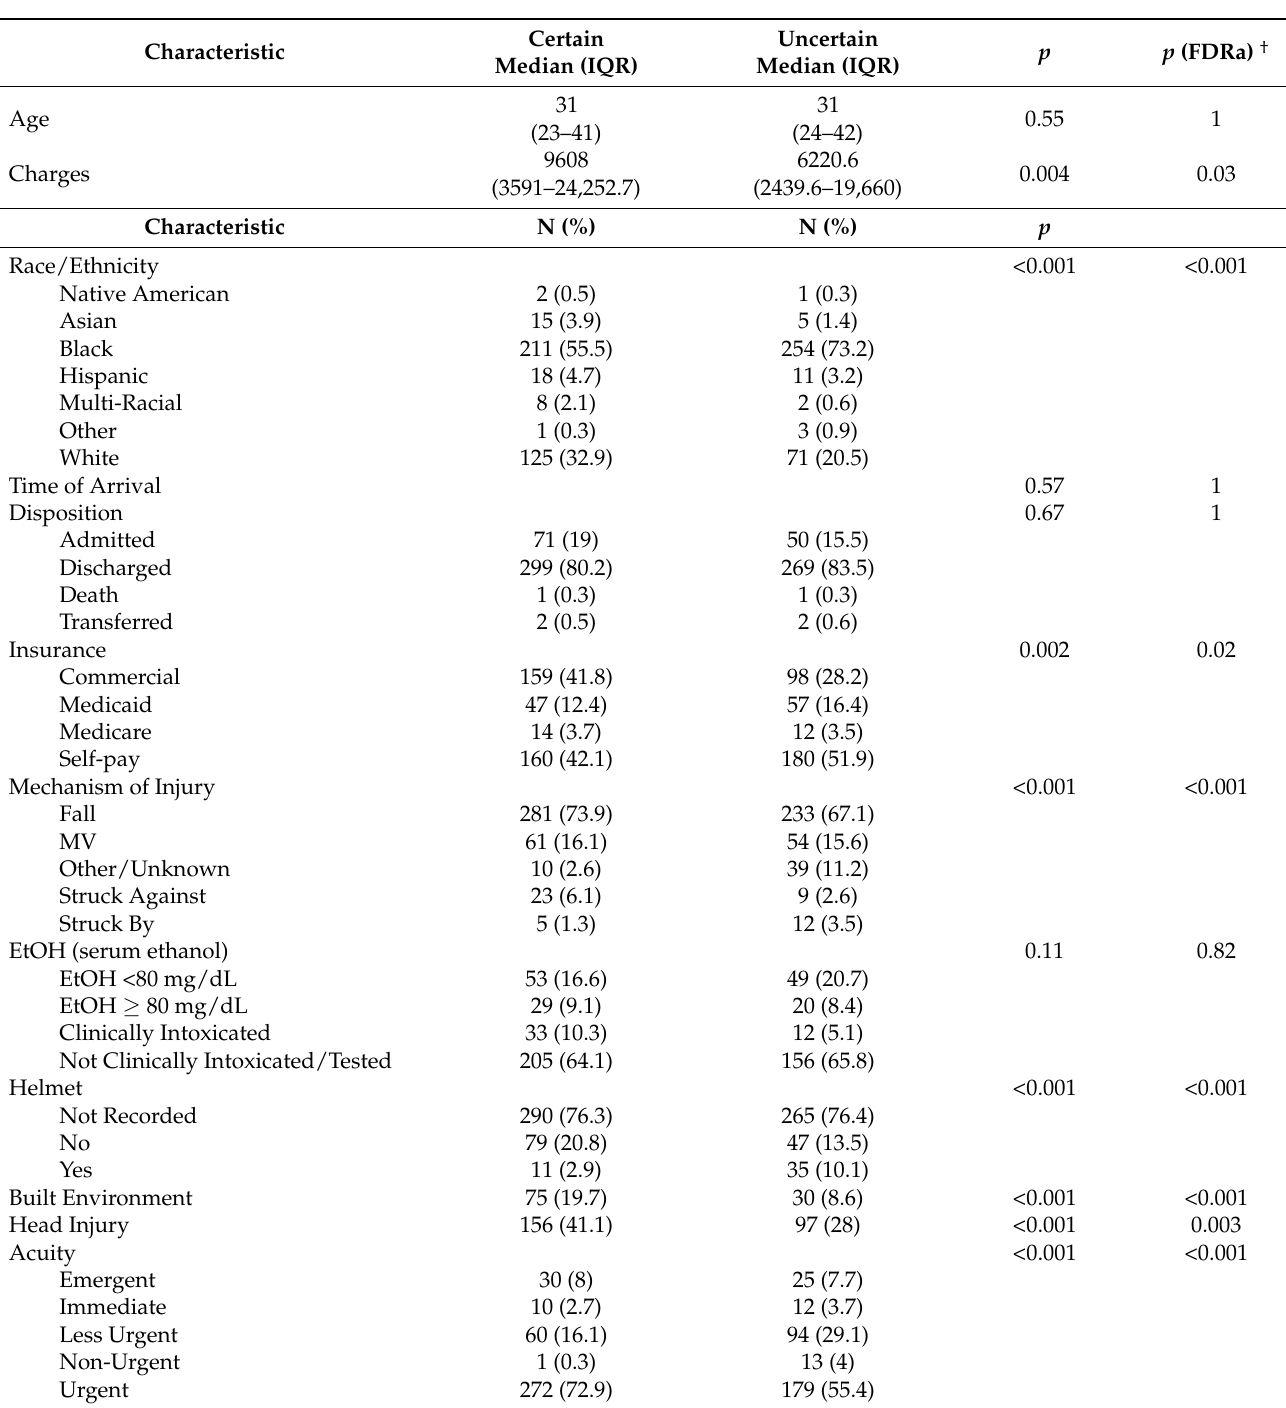
Table A1. Results of univariate statistical analysis comparing certain with possible bicycle